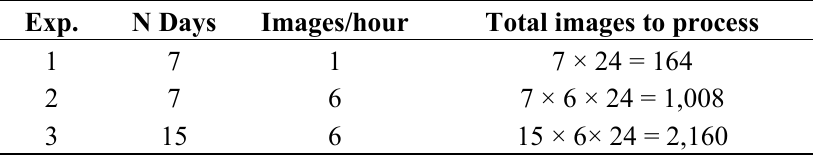
Table 1. The number of images generated for a single